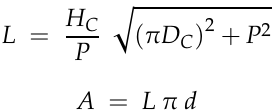
Table 3. Coil geometrical parameters of the investigated models